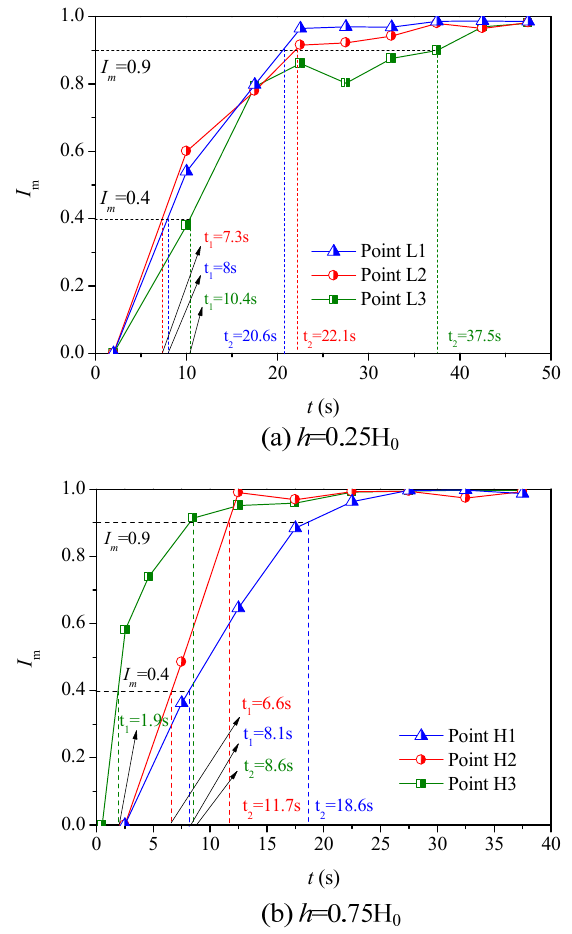
Figure 11. Variations of the micro mixing index at different lateral positions with time at different bed heights. ( a ) h = 0.25 H 0 . ( b ) h = 0.75 H 0